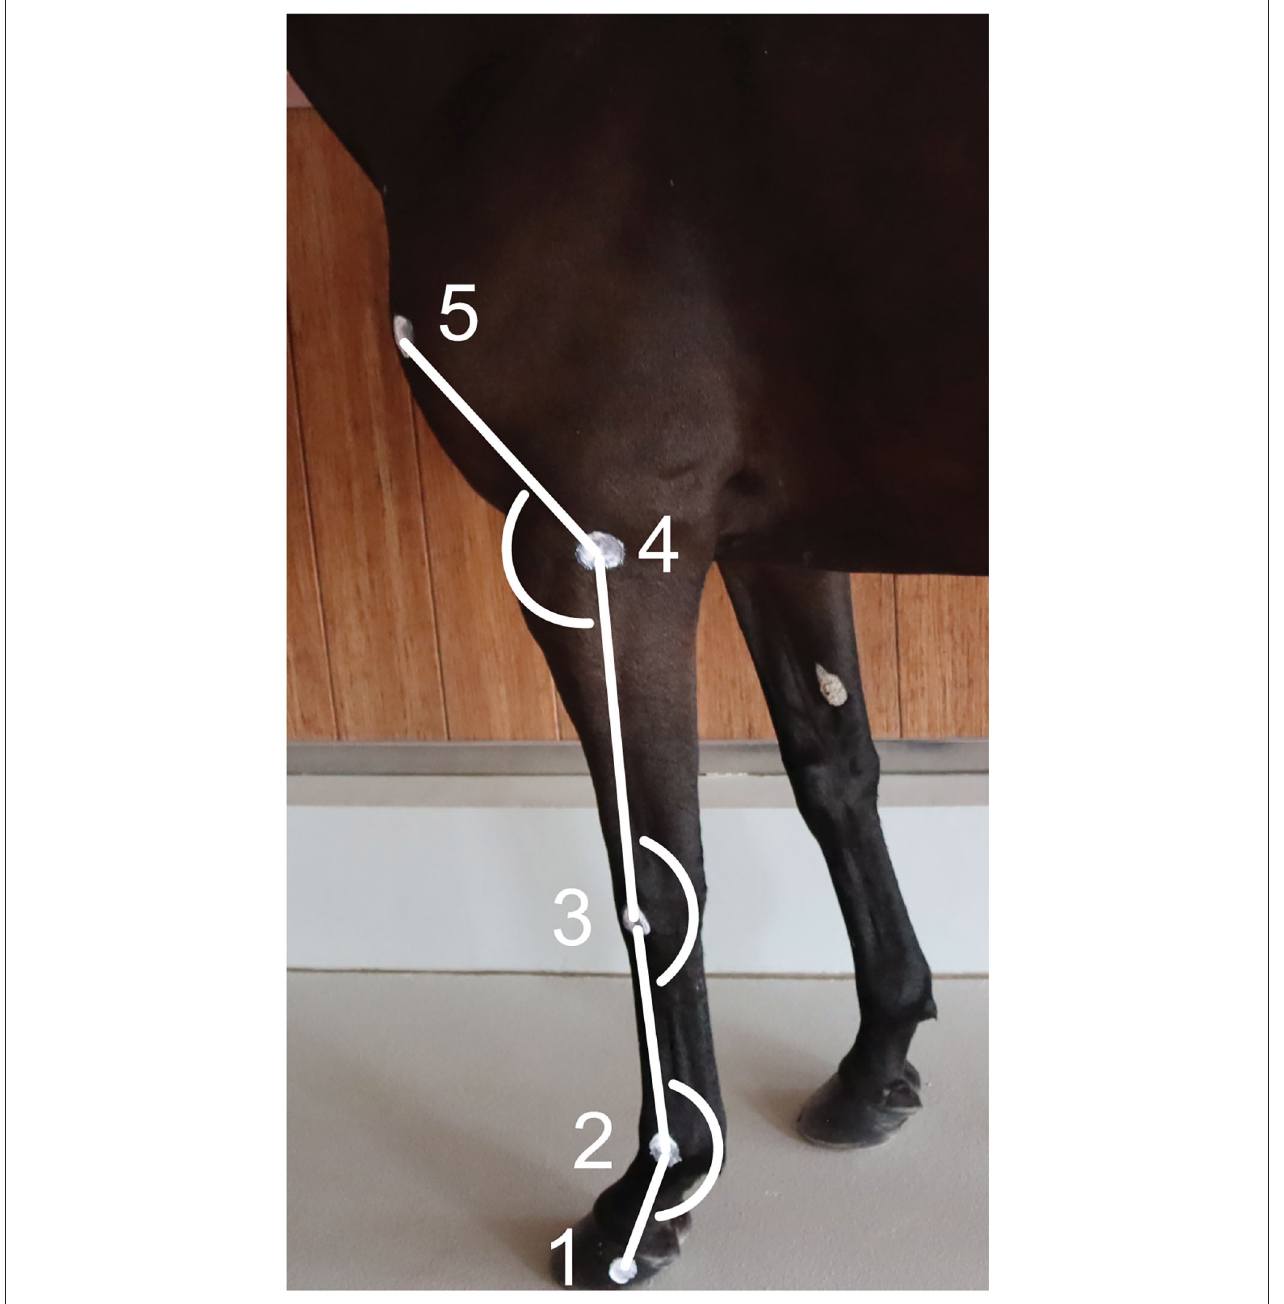
FIGURE 1 | Position of the markers on the forelimb’s anatomical landmarks and angles calculated. (1) Lateral hoof wall, (2) Lateral metacarpal epicondyle, (3) Ulnar carpal bone, (4) Lateral humeral epicondyle, and (5) Greater tubercle of the humerus.